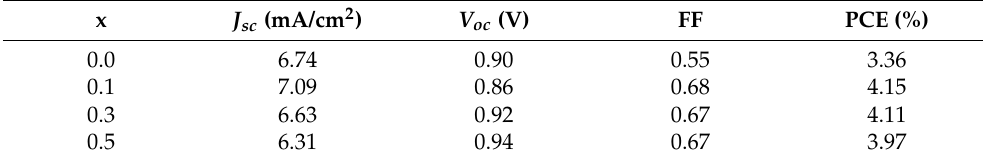
Table 1. Photovoltaic performance parameters of the lead halide solar cell at different molar ratio of PbBr 2 . x